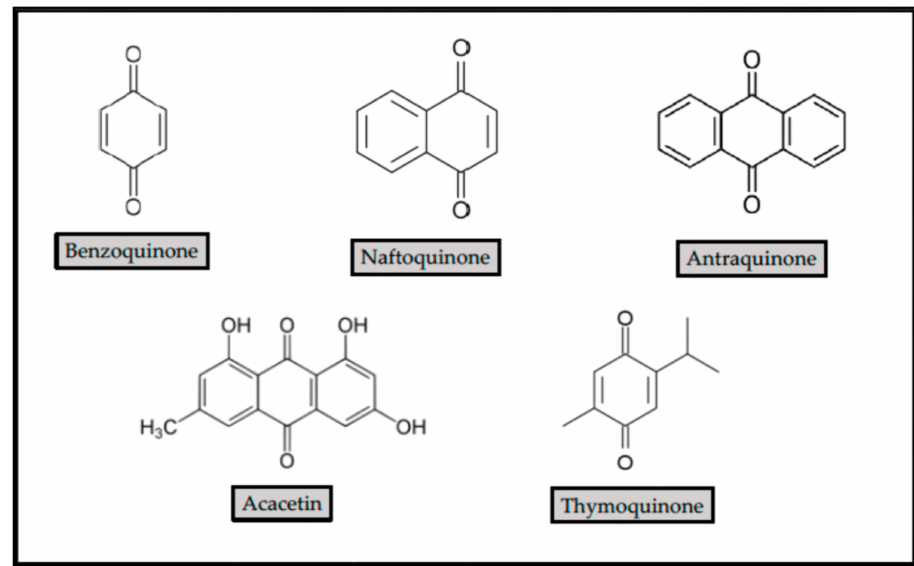
Figure 3. Structure of main quinone groups, and two quinones with antibacterial properties, acacetin and